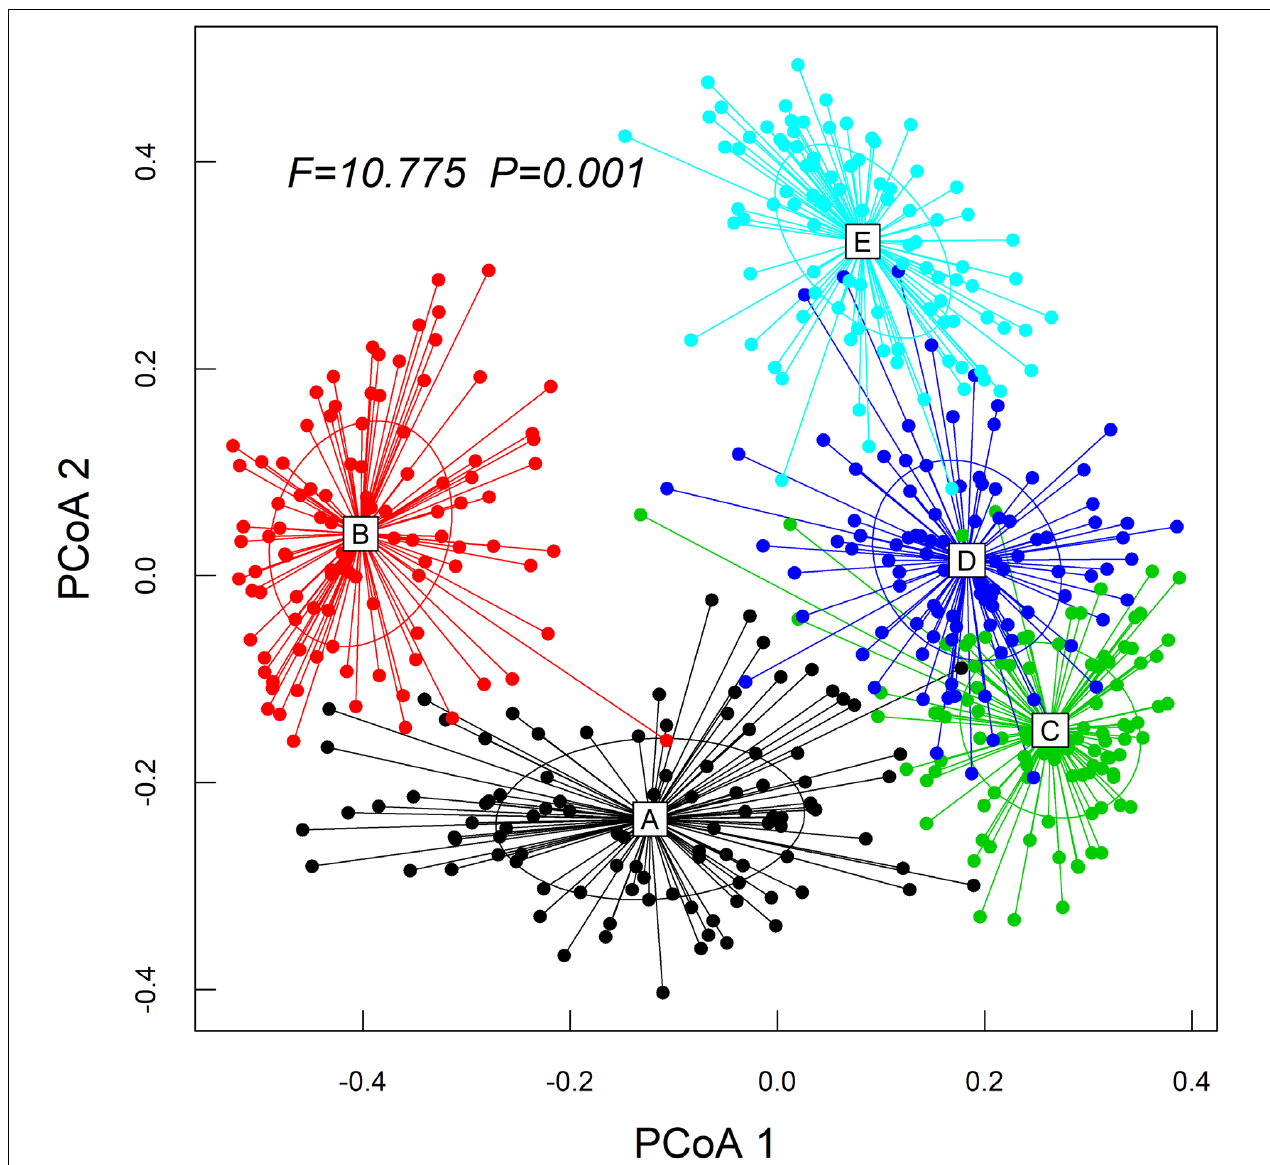
FIGURE 5 | Effect of community types on beta diversity of the woody plant by running the betadisper function. ANOVA was applied to test how these distances differed among the communities. PCoA1 and PCoA2 are the first and second sort axes in the “betadisper” analysis, respectively.